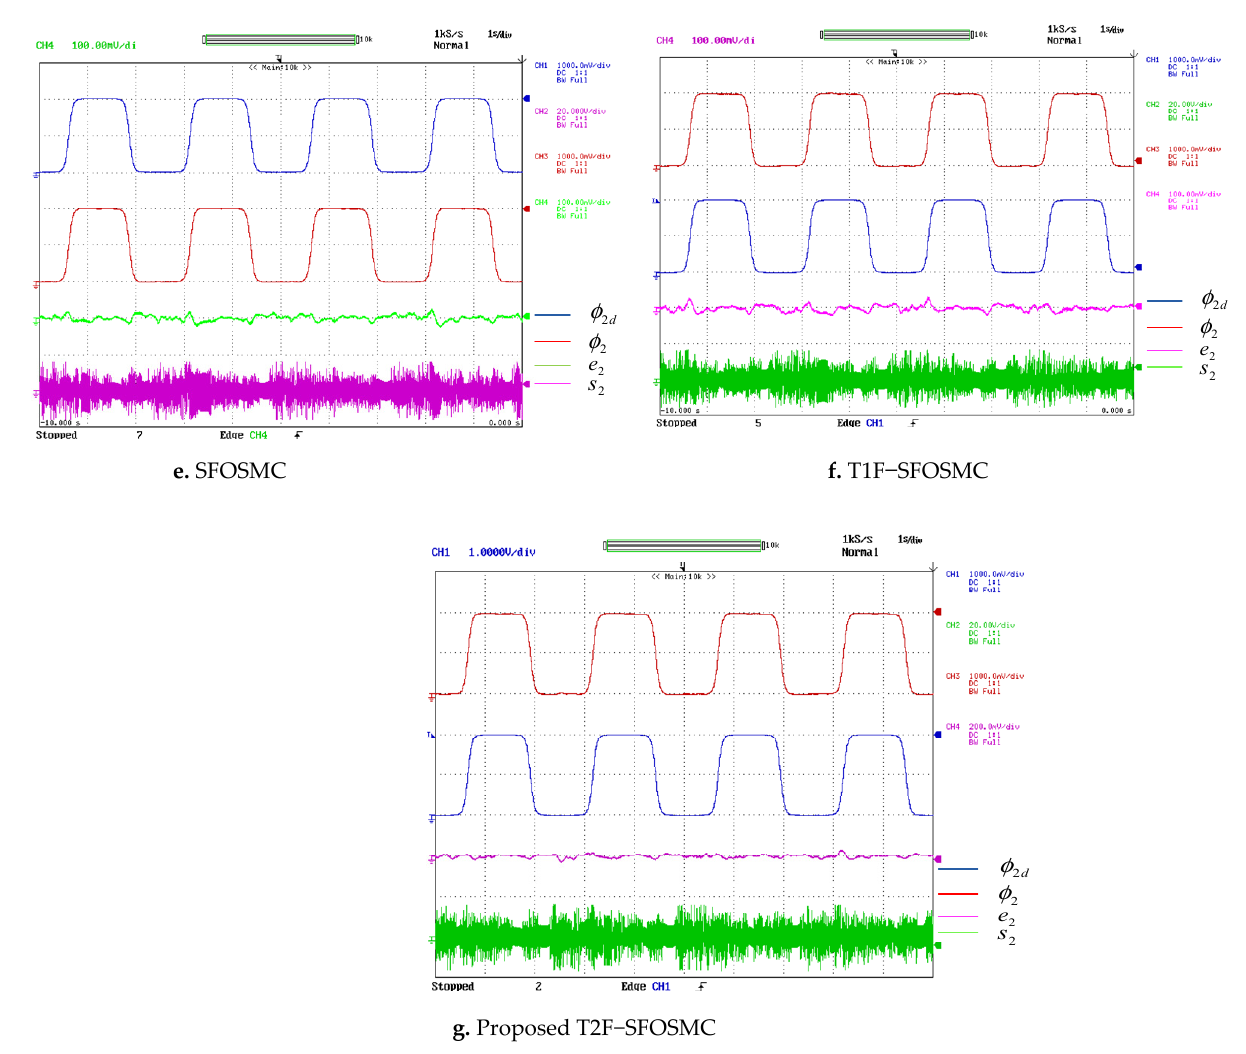
Figure 14. Trajectory tracking of the 3DOF surgical manipulator for Joint2.